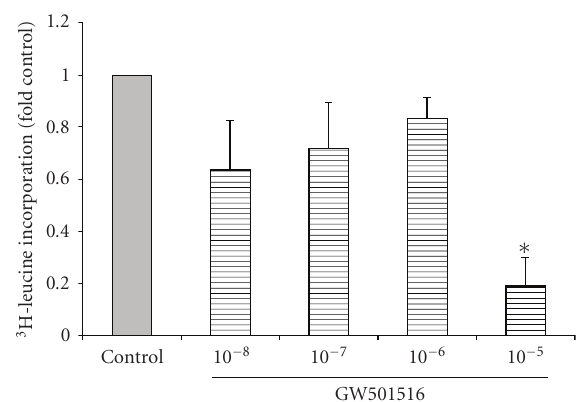
Figure 6: GW501516 causes a decrease in protein synthesis at high doses. Serum-starved cells were stimulated for 24 hours with serum- free media (control) or increasing concentrations of GW501516 (10 − 8 to 10 − 5 M) 3 H-leucine was added to IMCD-K2 cells while they were being stimulated and leucine incorporation was measured in counts per minute using a scintillation counter, and expressed as fold control. Values are mean ± S.E.M.; n = 3–5. ∗ P < . 05 compared to control.